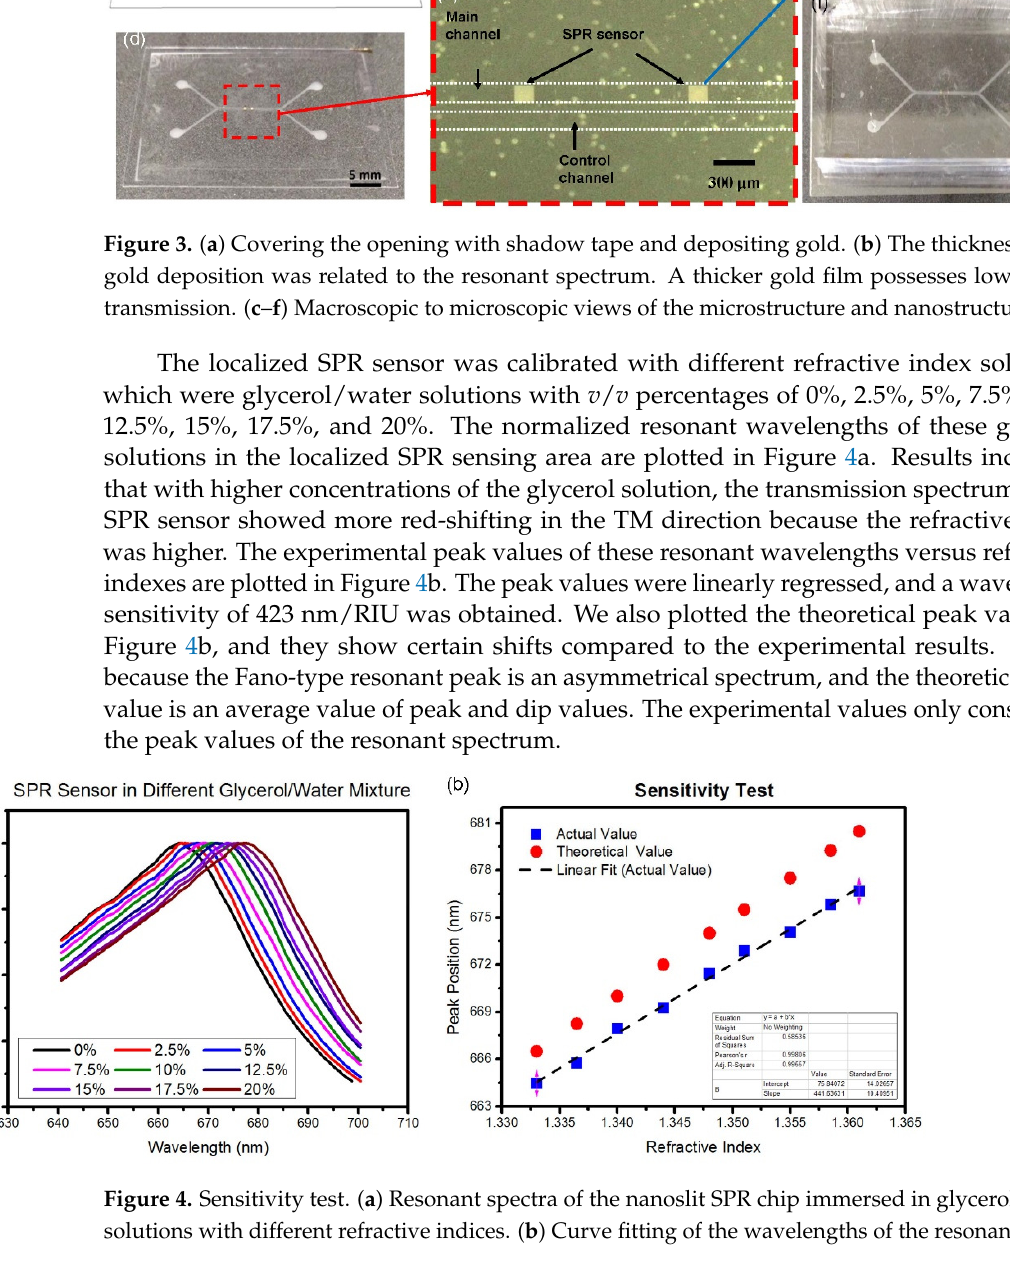
( b ) Figure 5. ( a ) Observation of resonant spectrum shifting when antigen and antibody were sequen- tially conjugated onto the nanoslit surface. ( b ) Analytical results of resonant spectra when the sens- ing chip was immersed in various concentrations of sample solutions. (Black dots and lines are av- eraged peak values and standard deviations of resonances when measuring various concentrations of LMP 1 antigen in three times, and red dot line is linear regression results of these averaged peak values )